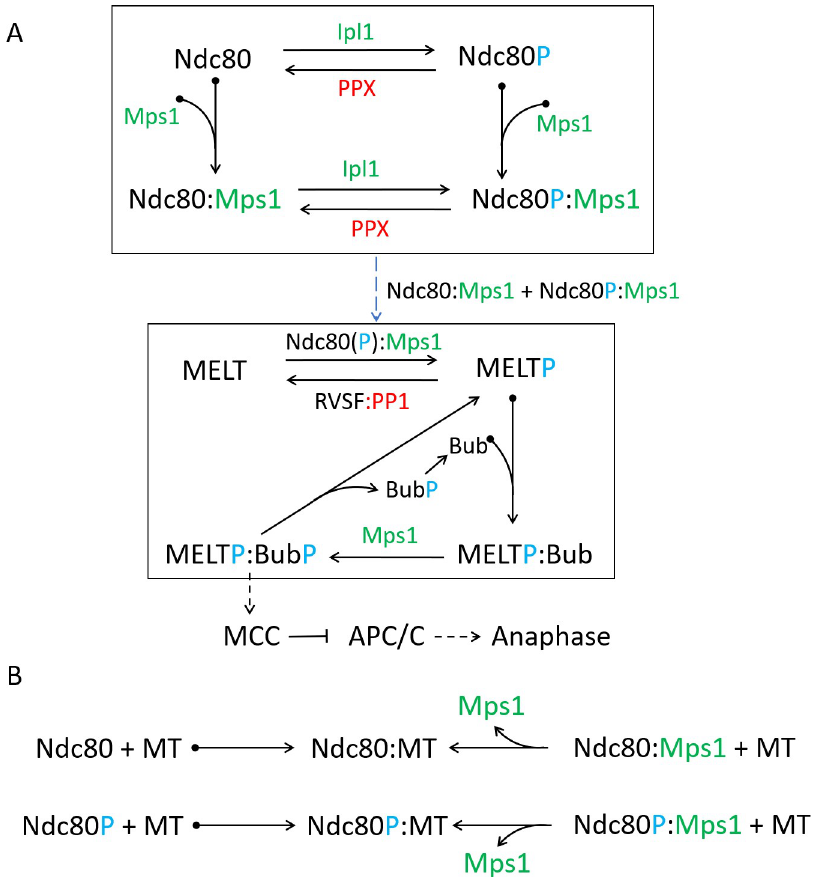
Fig 3. Molecular interactions at the KT. (A) Model of kinase (green) and phosphatase (red) activities at the KT, derived from the scheme in Fig 2. The full scheme can be divided into two modules (shown within boxes), namely, Ndc80 and MELT modules. See text for a detailed description of each module. ‘P’ (blue color) is used to depict the phosphorylation status of different motifs. The dashed arrow between the boxes indicates that Mps1 bound to either Ndc80 or Ndc80P phosphorylates MELT repeats. (B) Scheme showing binding of Ndc80 to MT. The reactions on the first line show that Ndc80 (unphosphorylated) binds reversibly to a MT, stabilizing the attachment, and that Ndc80: Mps1 can also bind to a MT, which displaces Mps1 in an irreversible reaction. (MTs and Mps1 compete for the same binding site on Ndc80; therefore, upon MT binding, Mps1 is displaced from Ndc80.) We assume that Ndc80P (and Ndc80P:Mps1) can also bind to MTs (second line of reactions), but with a much larger dissociation constant, i.e., phosphorylation of Ndc80 promotes detachment of the MT from a KT.